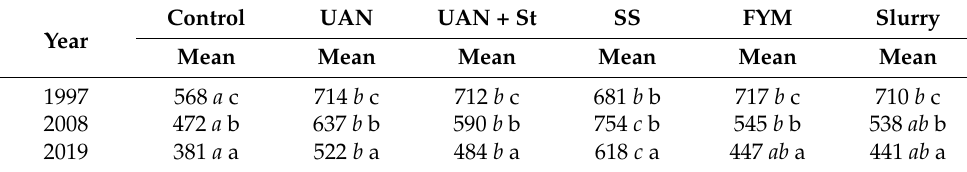
Table 5. Plant sulfur content (mg S kg − 1 ) after harvest in dry biomass ( n = 8). Year